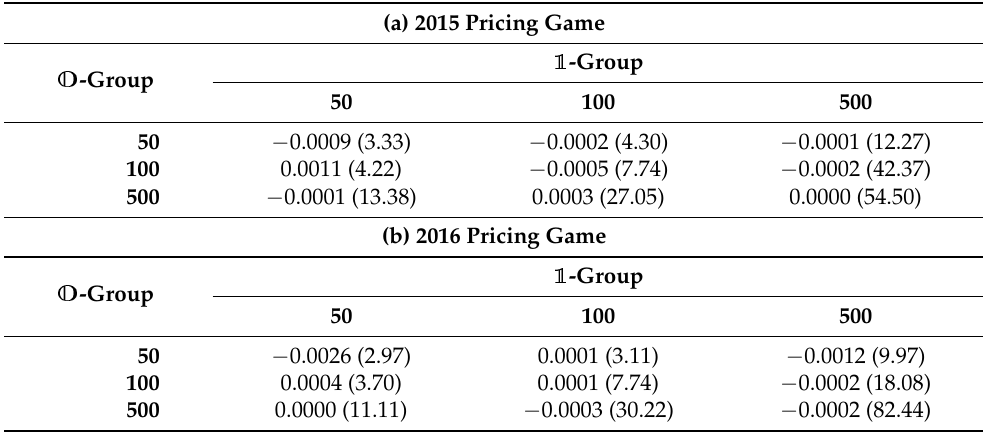
Table A6. Bias and run time (s), the latter between brackets, for the approximation ˆC on the 2015 and 2016 pricing game dataset. This is given for the rough grid approach and for several different numbers of clusters for the O - and 1